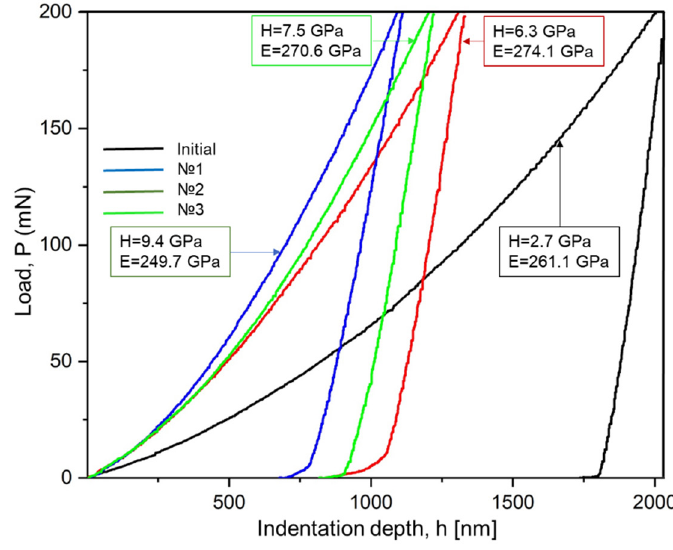
Figure 5. Load–displacement curves for steel 40 Kh before and after EPTCH.